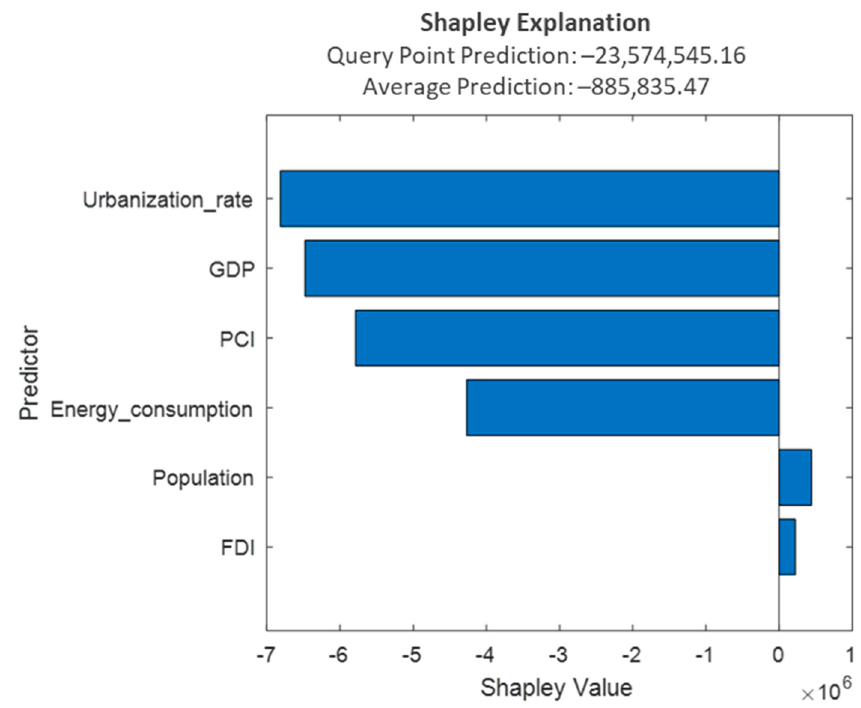
Figure 8. Shapley explanation of the predictors.